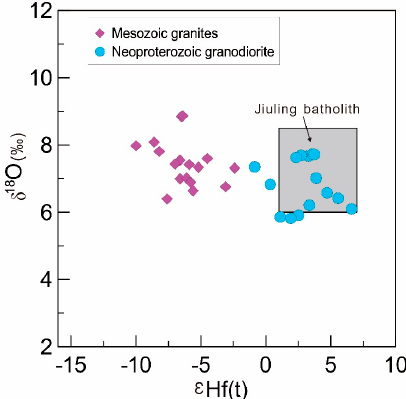
Figure 9. ε Hf(t) vs. δ 18 O for the zircons from the Shimensi granodiorite. Data of the ore-related Mesozoic Shimensi granites are from Wei et al. [6]. Jiuling batholith data are from Zhao et al. [24], Li et al. [25], Wang et al. [43].